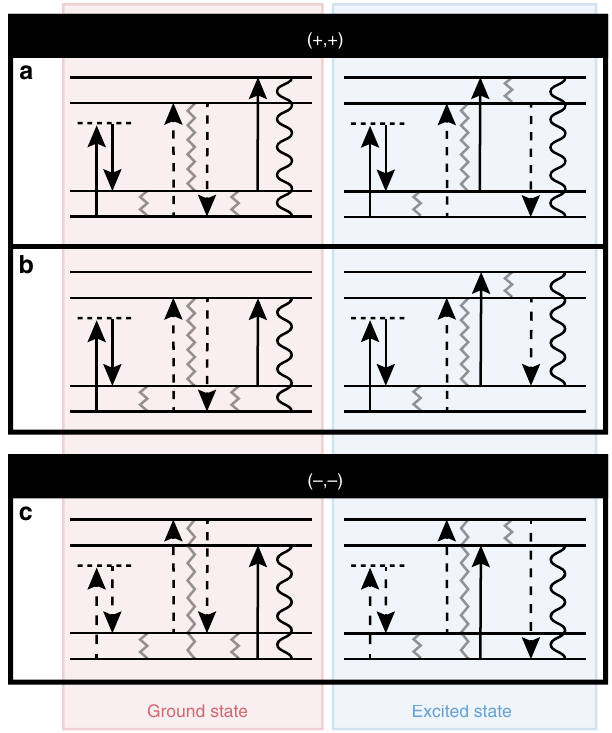
Figure 5 | Coherence pathways involving correlated Raman vibrations. Energy ladder diagrams (that is, wave mixing diagrams) depict vibrational coherence pathways that yield the diagonal Raman peaks in ( a , b ) the ( þ , þ ) quadrant and ( c ) the ( (cid:4) , (cid:4) ) quadrant of the six-wave mixing 2D beating slice (6WM-2DBS) spectrum (Fig. 3b). These pathways are consistent with the Raman frequency–dependent peak shifts observed in the six-wave mixing beating map (6WM-2DBM) spectra (Fig. 4). Grey, zig-zag lines mark coherently linked vibronic states during T 0 , t and T , and a black wavy line represents the final electronic coherence that radiates the signal during t